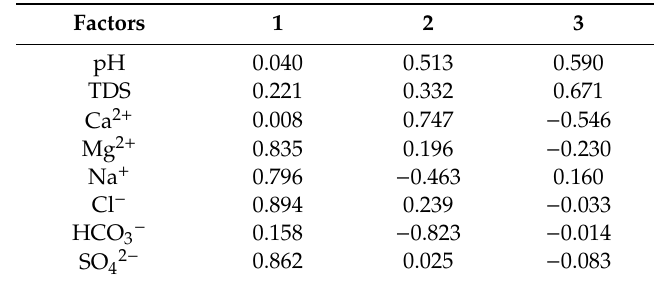
Table 5. Correspondence between principal components and